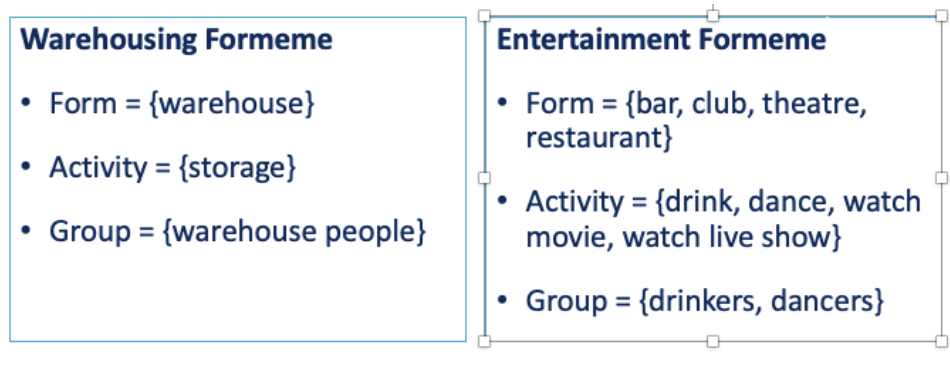
Figure 3. Example formemes.